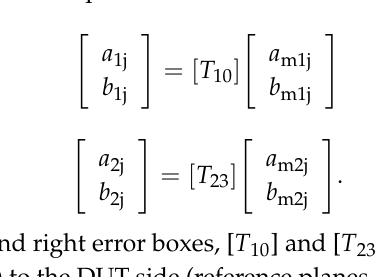
Figure 2. Single-port calibration. ( a ) Error model for standard R k1 measurement; ( b ) Error model for standard R k2 measurement.